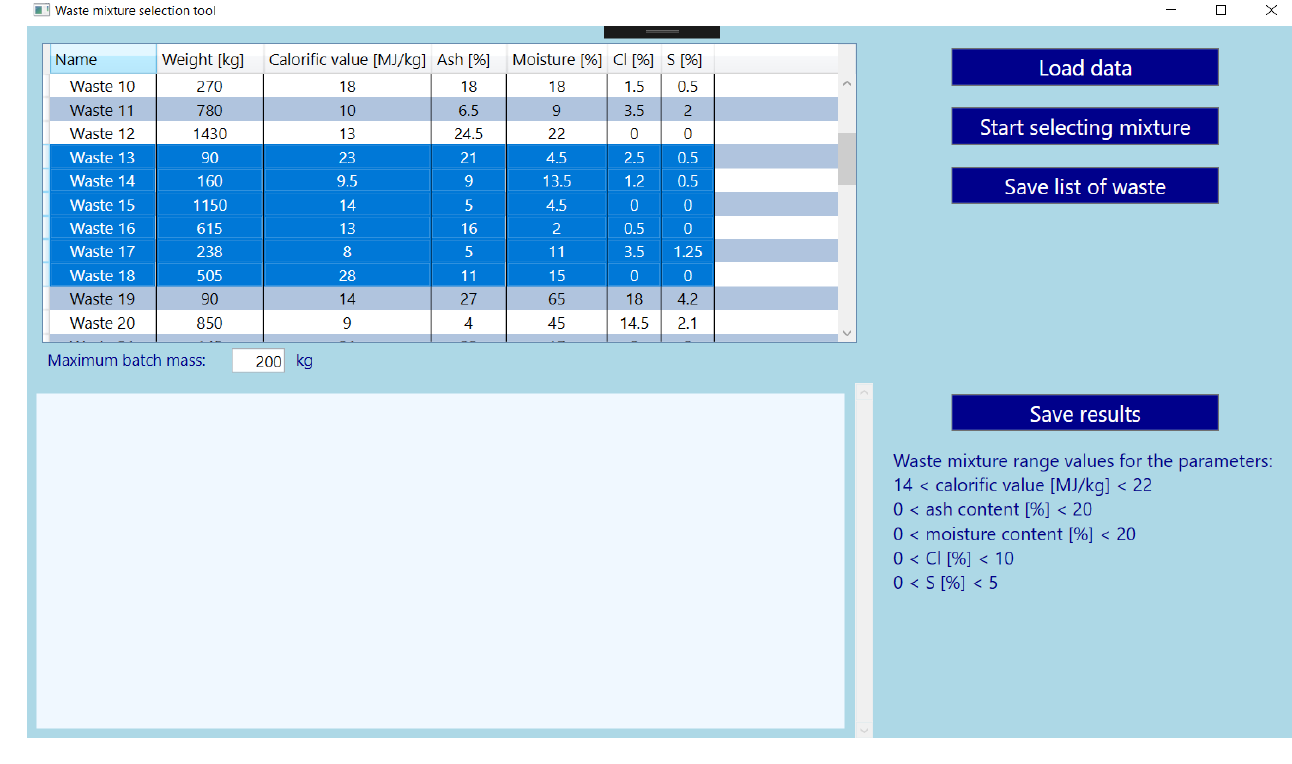
Figure 1. Functionality of the application.